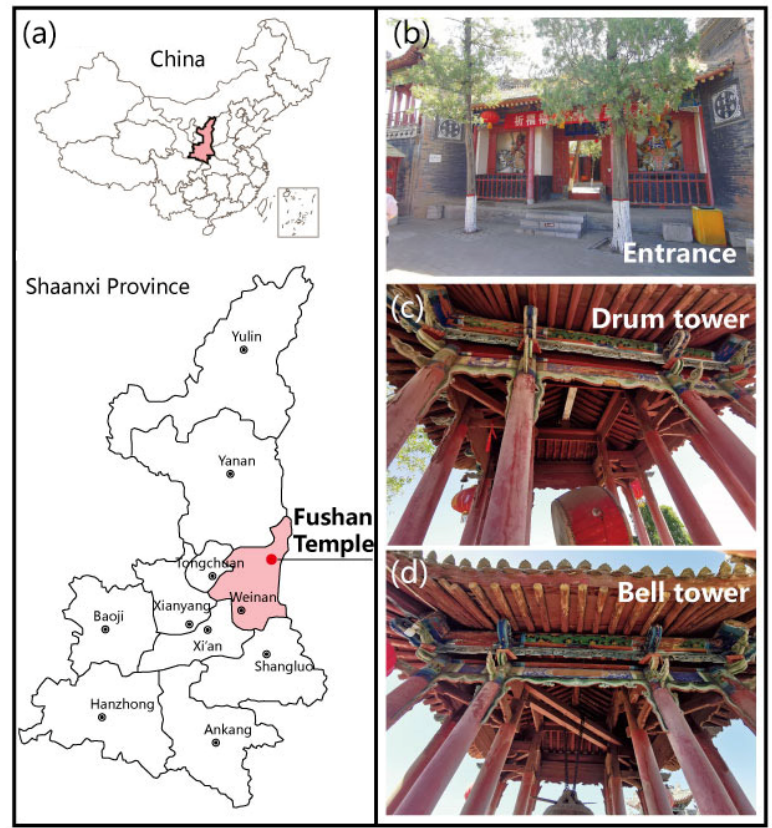
Figure 1. ( a ) the location of Fushan Temple in Weinan, Shaanxi Province, China; ( b ) the entrance of Fushan Temple; ( c ) the Drum tower; ( d ) the Bell tower.